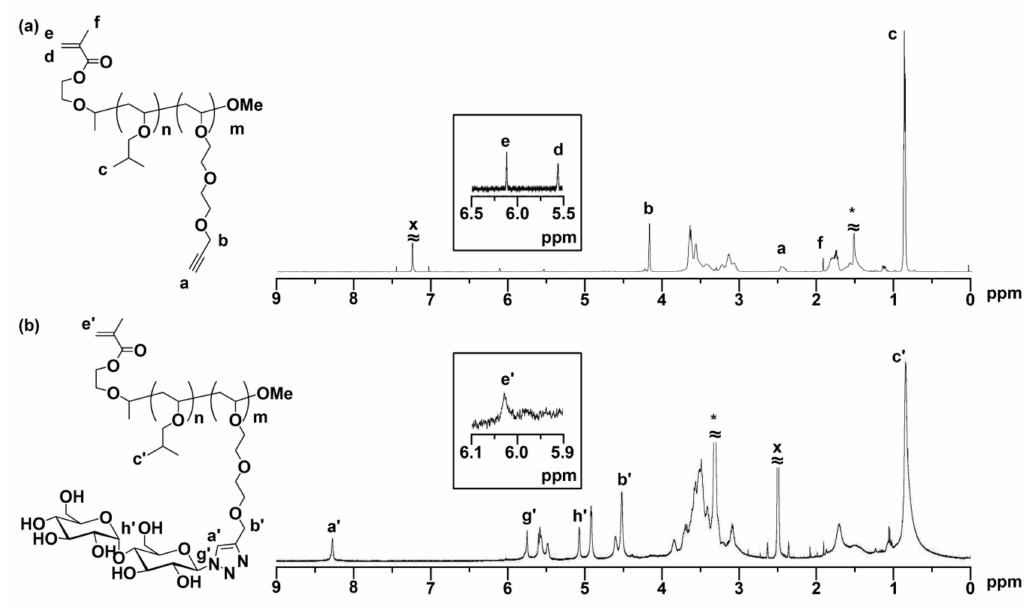
Figure 3. 1 H nuclear magnetic resonance (NMR) spectra of ( a ) MA-PIBVE 25 - b -PVEEP 10 in CDCl 3 and ( b ) MA-PIBVE 25 - b -P(VE-Mal) 10 in DMSO- d 6 ( × and *; remaining